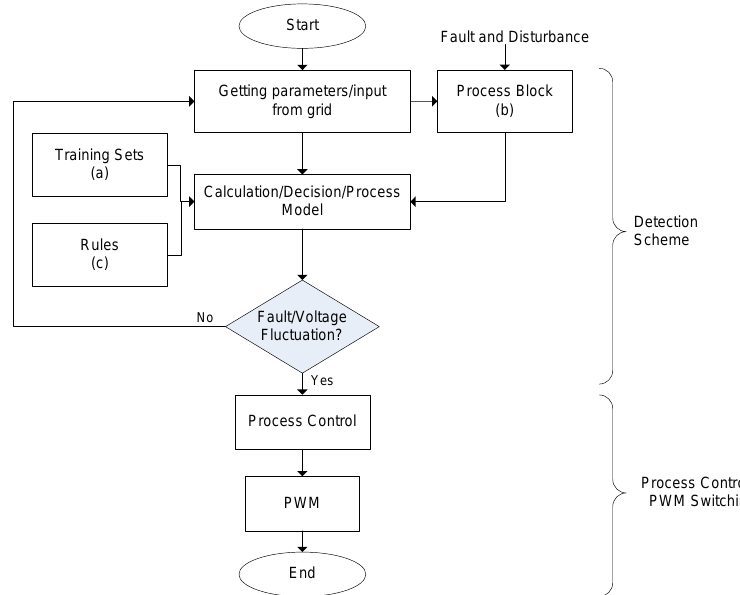
Figure 15. Flow-of-work on the detection method along with a control scheme for non-linear conditions (a) data-driven [158] (b) process model [161] (c) knowledge based [164].